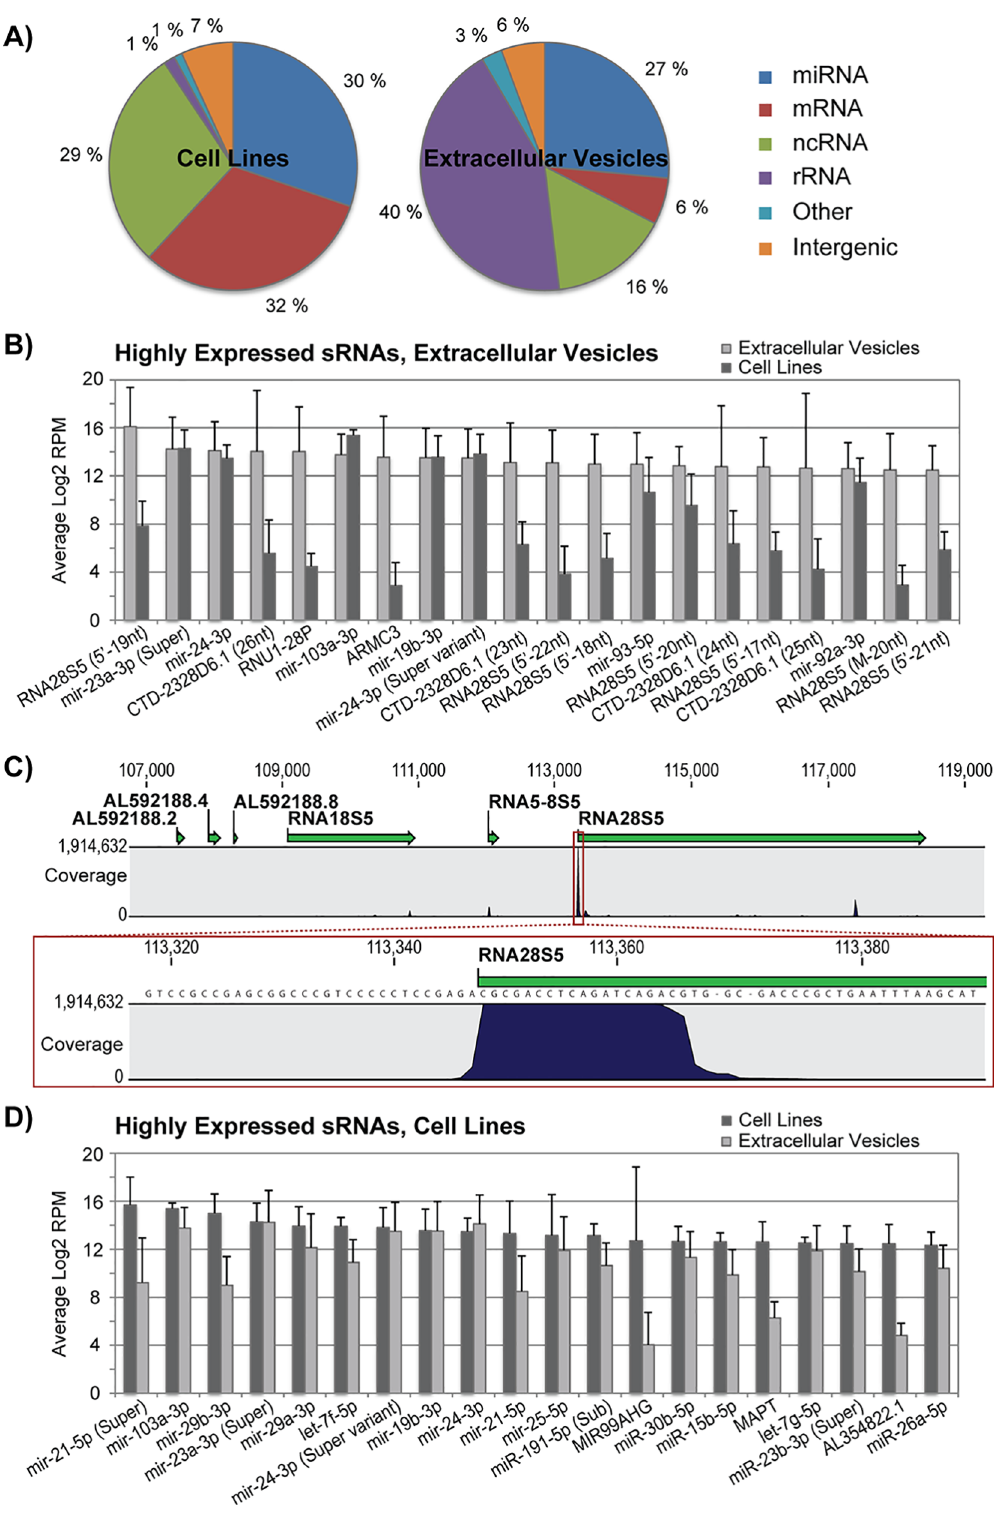
Fig 3. The group of non-miRNA small RNA species distinguished the EVs from their parental cell lines. A) Transcriptome subtype distribution of small RNA sequence reads combined for the nine breast cancer cell lines and for the nine breast cancer EVs. B) The expression level of the 20 most abundant small RNAs in the EVs is